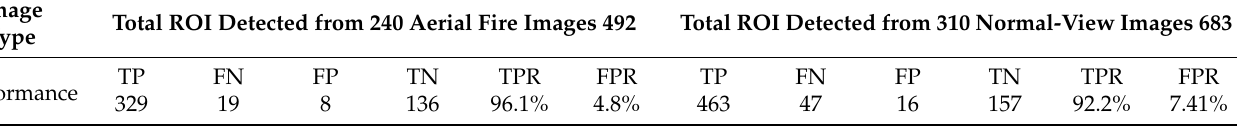
Table 2. The performances of the location and segmentation methods.